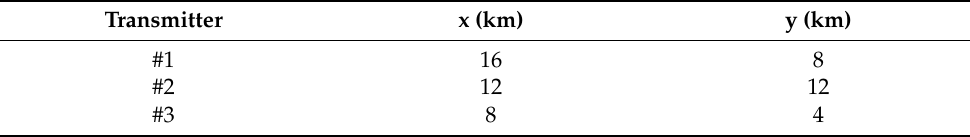
Table 5. Receiving antennas positions.